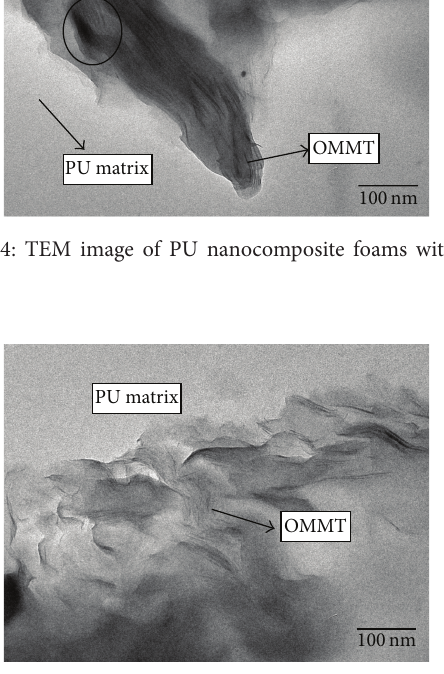
Figure 15: TEM image of PU bionanocomposite foams with 5wt%